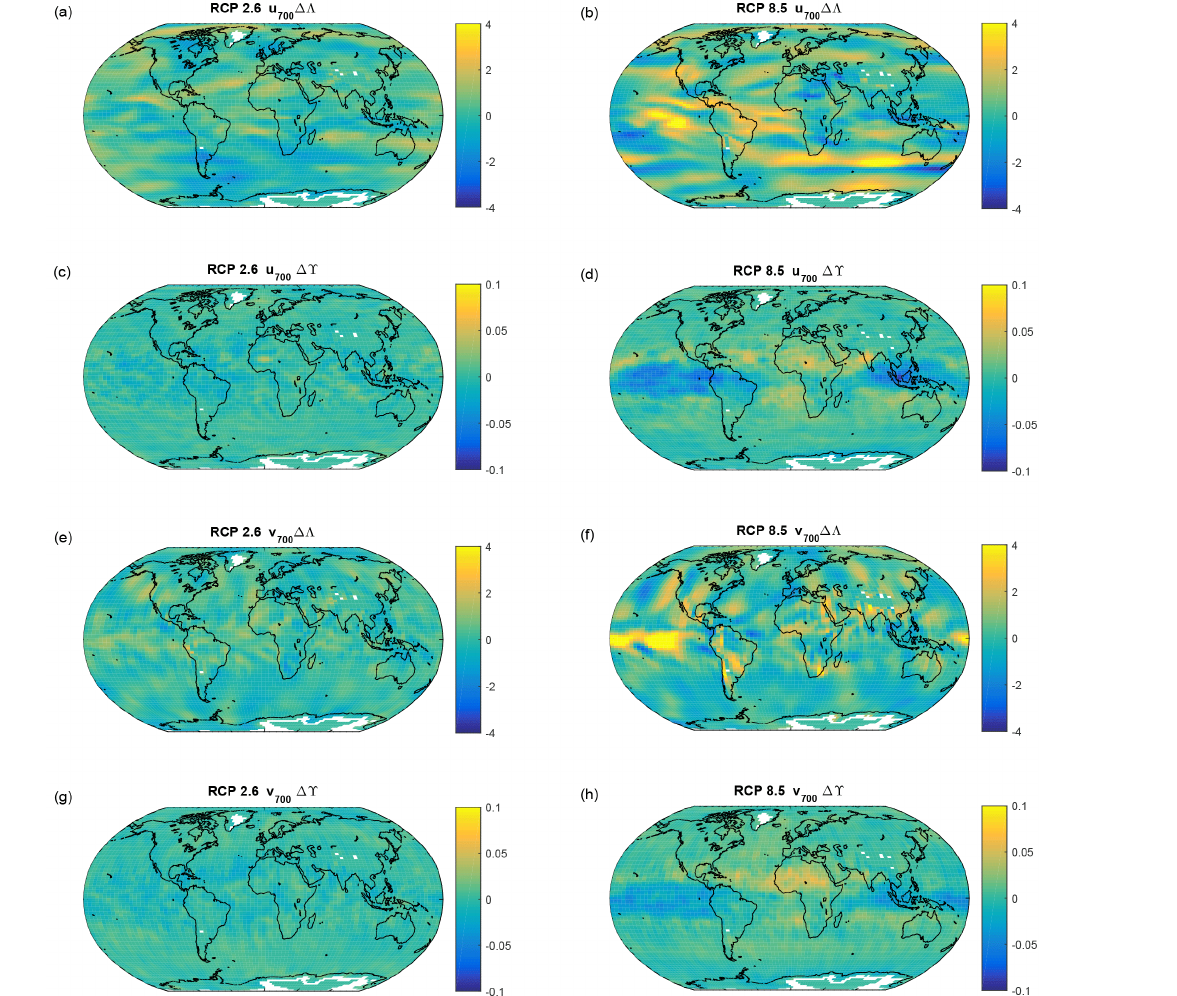
Figure 3. Differences in the integral of the autocorrelation function (cid:49)(cid:51) for the 2055–2105 and the 2005–2055 period for the u 700 in the RCP 2.6 (a) and in the RCP 8.5 (b) . Differences in the spectral complexity (cid:49)ϒ for the 2055–2105 and the 2005–2055 period for the u 700 in the RCP 2.6 (c) and RCP 8.5 (d) scenario. (cid:49)(cid:51) for v 700 for the RCP 2.6 (e) and the RCP 8.5 (f) scenarios. (cid:49)ϒ for the v 700 in the RCP 2.6 (g) and RCP 8.5 (h)